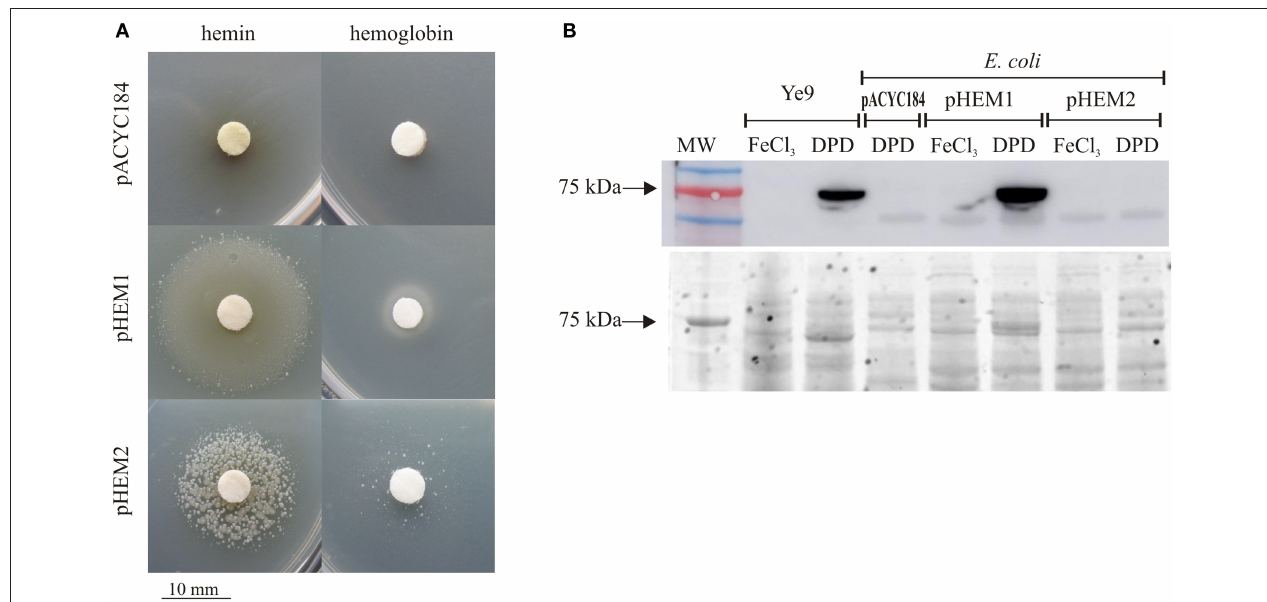
FIGURE 4 | Growth promotion of E. coli 1 hemA strain SASX77 expressing receptors HemR1 or HemR2 in the presence of hemin and hemoglobin as porphyrin sources. (A) Ability of the E. coli 1 hemA strain expressing HemR1 or HemR2 to utilize hemin and hemoglobin. Diluted overnight cultures of SASX77/pHEM1 and SASX77/pHEM2 were mixed with agarose and overlaid on LB or LBD agar plates. Sterile paper discs wetted with 10 µ l of hemin (10mM) or hemoglobin (0.1mM) were placed on these plates and zones of growth around these discs were analyzed after 1–4 days of incubation at 37 ◦ C. (B) Immunodetection of HemR1 in Y. enterocolitica Ye9N (wt) and E. coli SASX77 carrying plasmids pHEM1 (HemR + ), pHEM2 (HemR2 + ), or pACYC184. Cell extracts from overnight cultures were analyzed by Western blotting with a polyclonal antibody directed against HemR1 (upper) and by TGX Stain free ( lower , loading control). MW, 3-Color Prestained Protein Marker; kDa. This result is representative of at least three independent experiments.